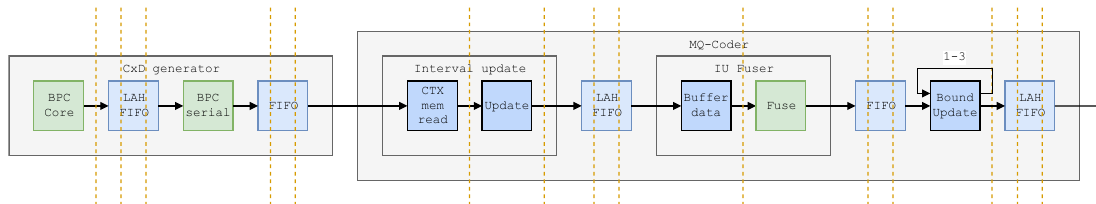
Figure 12. Detailed pipeline of the tier 1 coder. In dotted orange, the separation between stages. Each FIFO introduces two stages